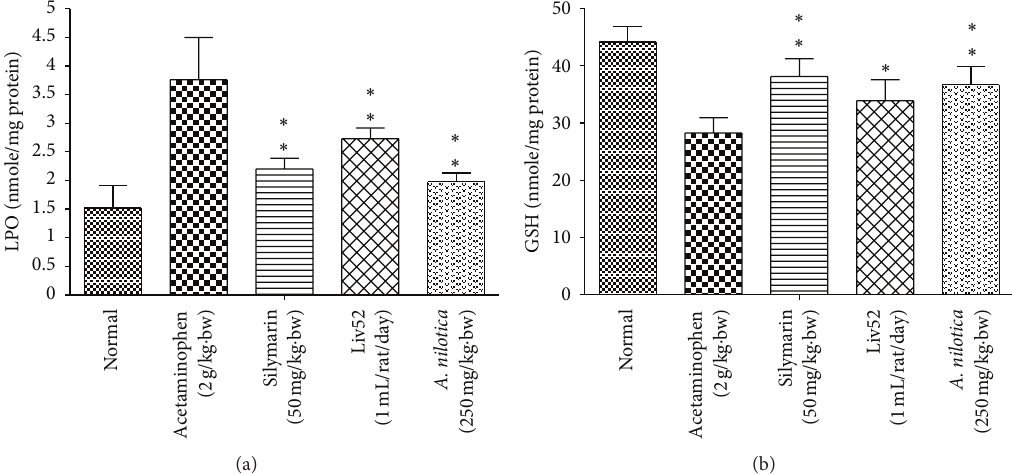
Figure 4: Effect of the methanolic extract of A. nilotica (250 mg/kg ⋅ bw) on LPO and GSH levels in acetaminophen-treated animals. Values are significantly different from acetaminophen-treated (nonextract-treated) control, ( ∗ 𝑃 < 0.05 , ∗∗ 𝑃 < 0.01